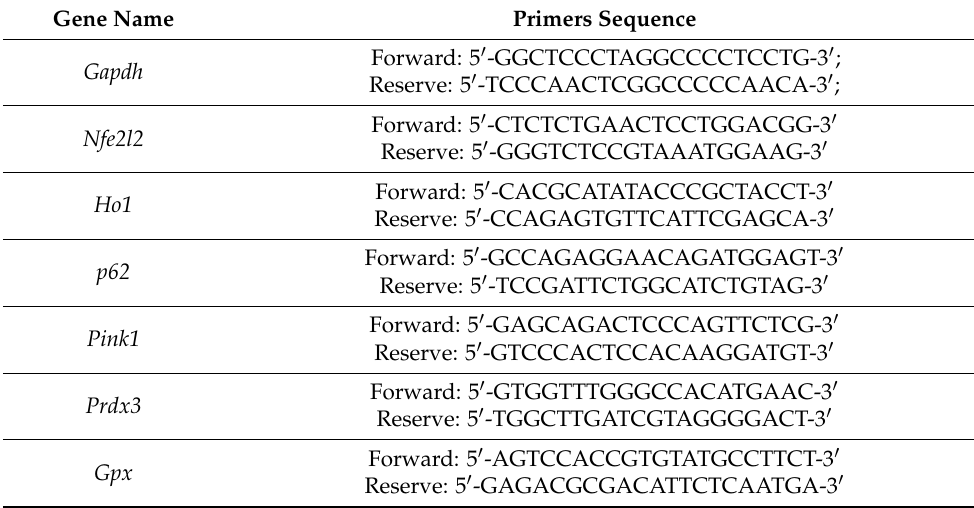
Table 2. Primers that were used to analyze gene